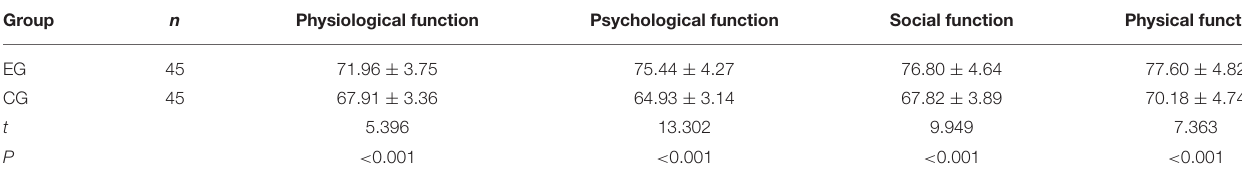
TABLE 4 | Comparison of QOL scores [Mean ± SD].